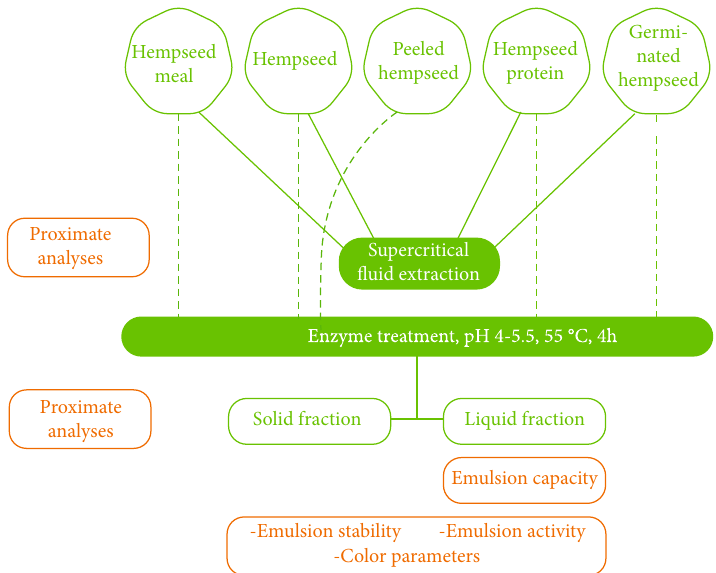
Figure 1: A fl ow chart of production solid and liquid fractions from di ff erent hempseed raw materials. Green indicates the materials and treatments used to produce solid and liquid fractions. Orange indicates the analysis methods. Dashed lines indicate the direct use of the starting material in enzymatic treatments without supercritical fl uid